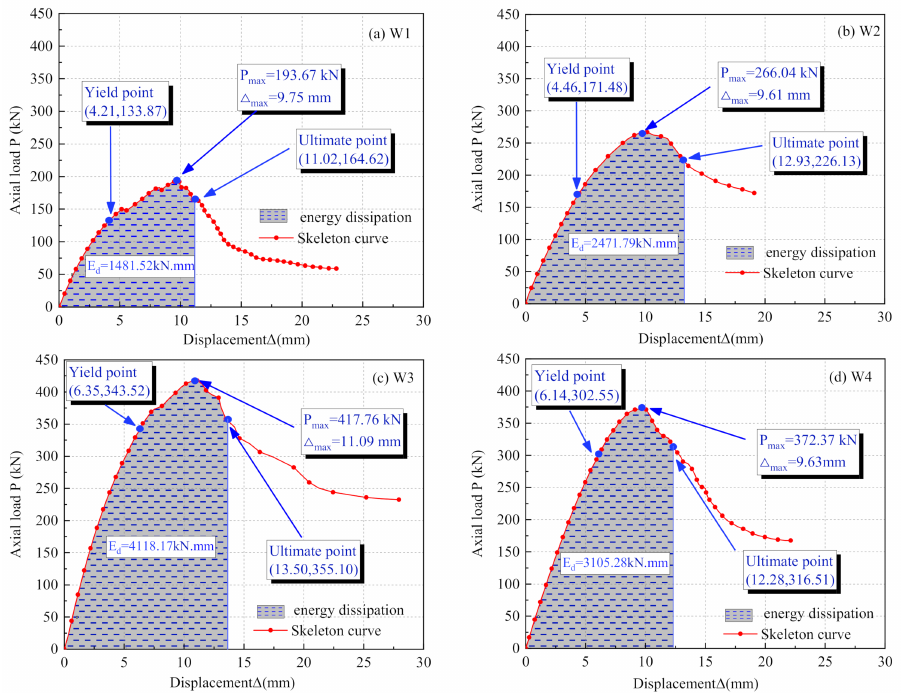
Figure 9. Vertical load–displacement